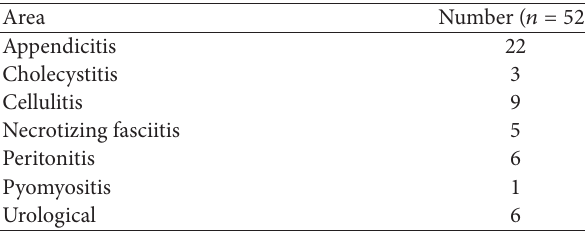
Figure 3: Operating doctor.